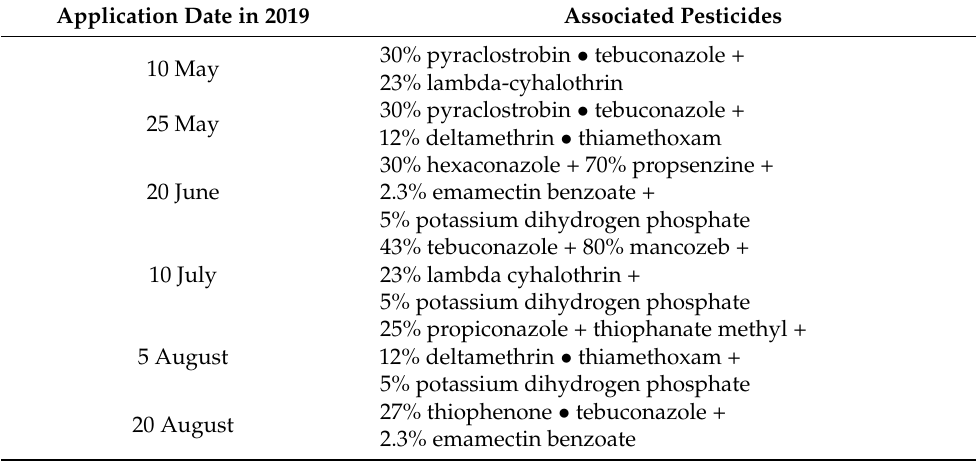
Table 1. Management of the spray program using pesticides for pest and disease control used in the current study to evaluate the effects of bagging (R5)- and non-bagging (R3)-based management practices on the microbiota of apple